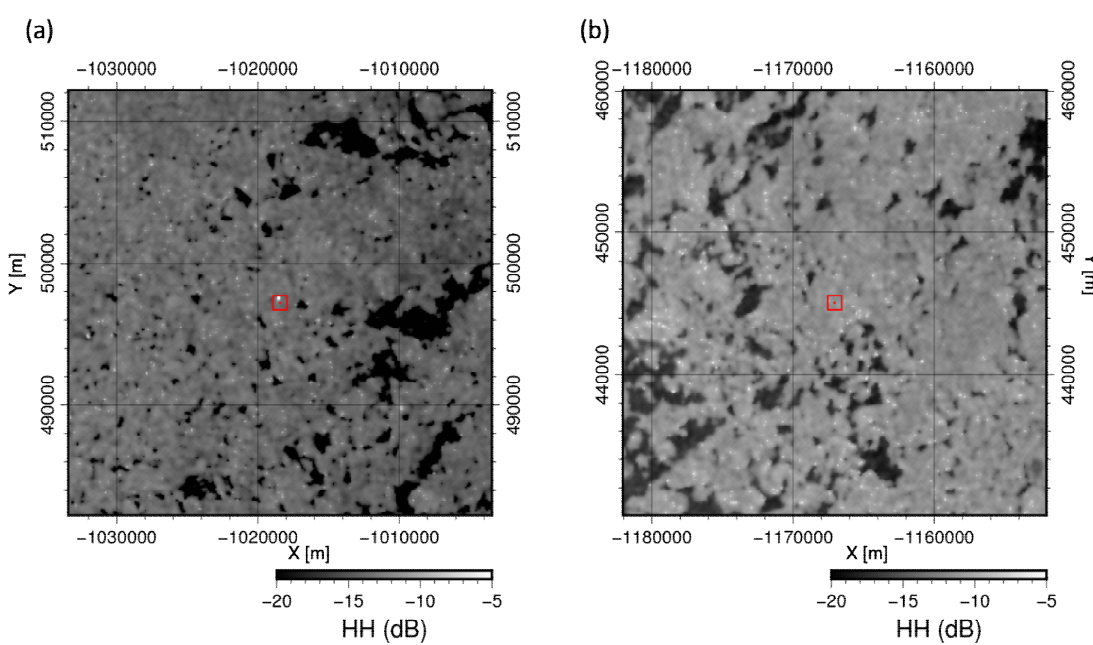
Figure 4. (a) Sentinel-1B image in HH-polarization, acquired at 17:53 UTC (08:53 local time in Alaska) on 14 August 2019. The bright signal is IBRV Araon. (b) Sentinel-1B image at 17:45 UTC (08:45 local time in Alaska) on 2 September 2019, the surround of the ice floe became indistinguishable. A red square indicates the sample window within which backscatter statistics were calculated.